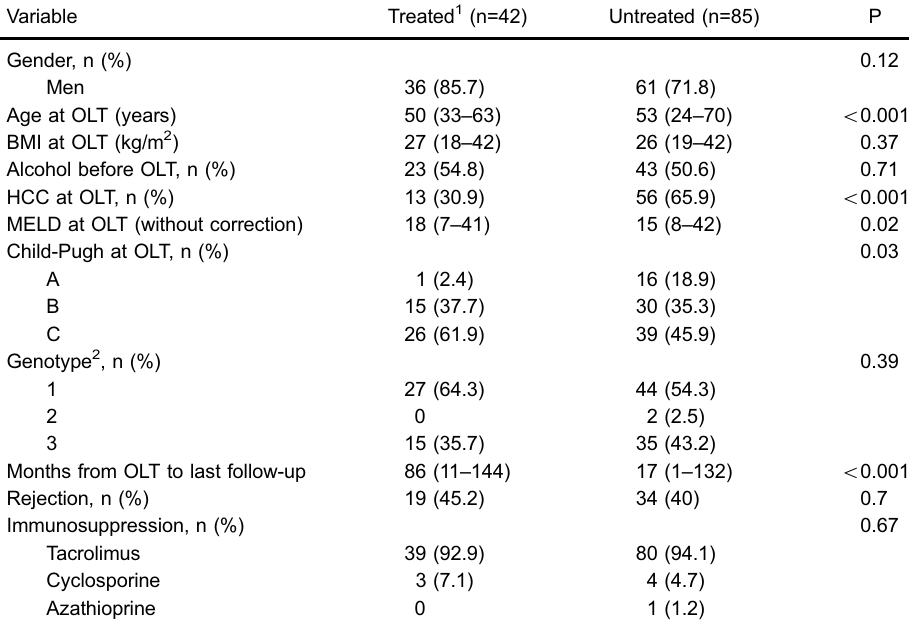
Table 1. Baseline features of interferon-treated vs untreated patients who had recurrent hepatitis C viral (HCV) infection after orthotopic liver transplantation.